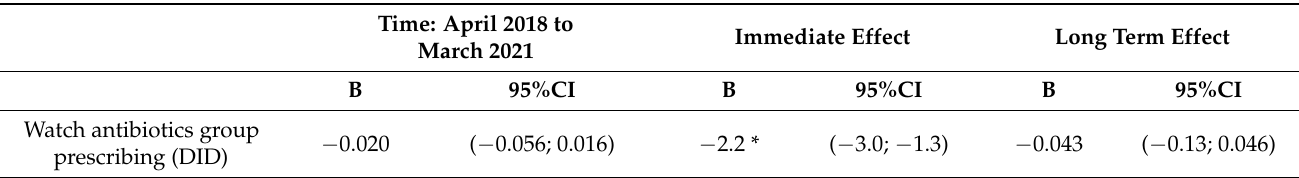
Figure 3. Monthly prescribing trend of antibiotics from the Watch WHO group as DID prescribed in outpatient care. Blue line ( − ): tendency line, after model adjustment; blue dashed line: expected tendency line with no COVID-19 emergence; red dashed line: COVID-19 emergence (March 2020); + : antibiotic monthly prescription in DID. Table 3. Interrupted segmented regression time series analysis of the Watch antibiotics group prescribing as DID in outpatient care.